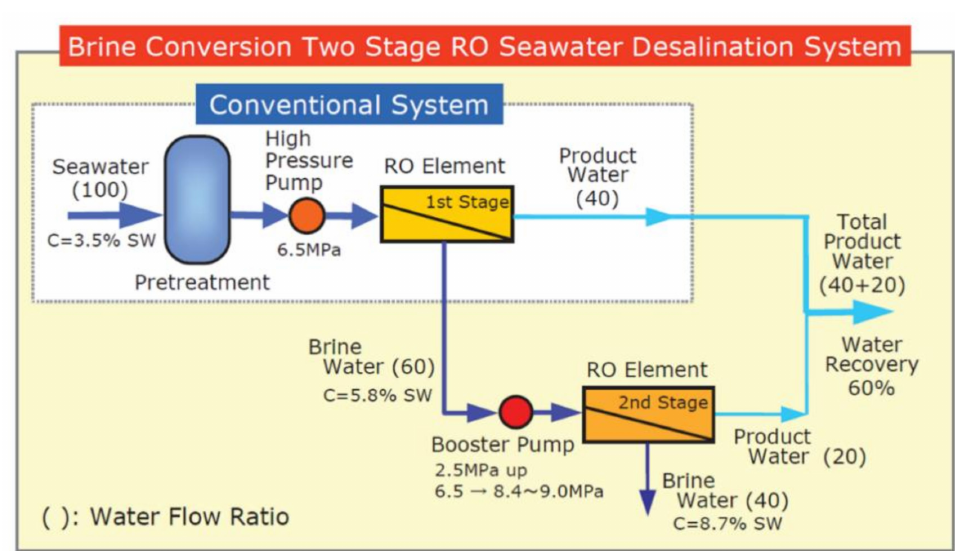
Figure 7. The schematic flow configuration of the brine conversion two stage RO system (BCS) with an example of flow balance